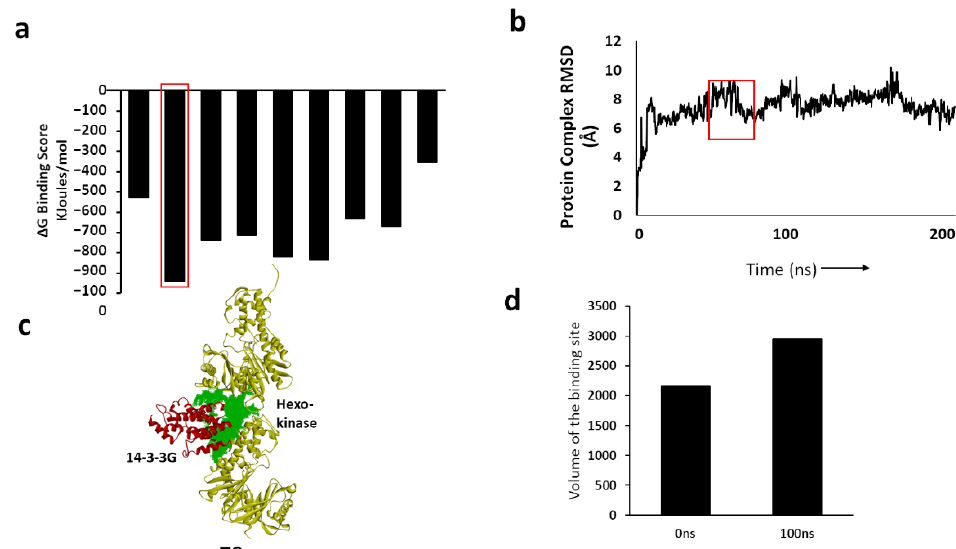
Figure 4. Prediction of an avid interaction between 14-3-3G and hexokinase. ( a ) Binding free energies of 14-3-3G with the principal interacting proteins. Note that hexokinase (HXK) is predicted to have the lowest free energy of binding. ( b ) RMSD plot of 14-3-3G bound to hexokinase over a 200-ns MD simulation; ( c ) 14-3-3 G::hexokinase complex showing binding pocket (green) at 70 ns. ( d ) The volume of the hexokinase binding pocket for 14-3-3G increases between 0 and 100 ns.